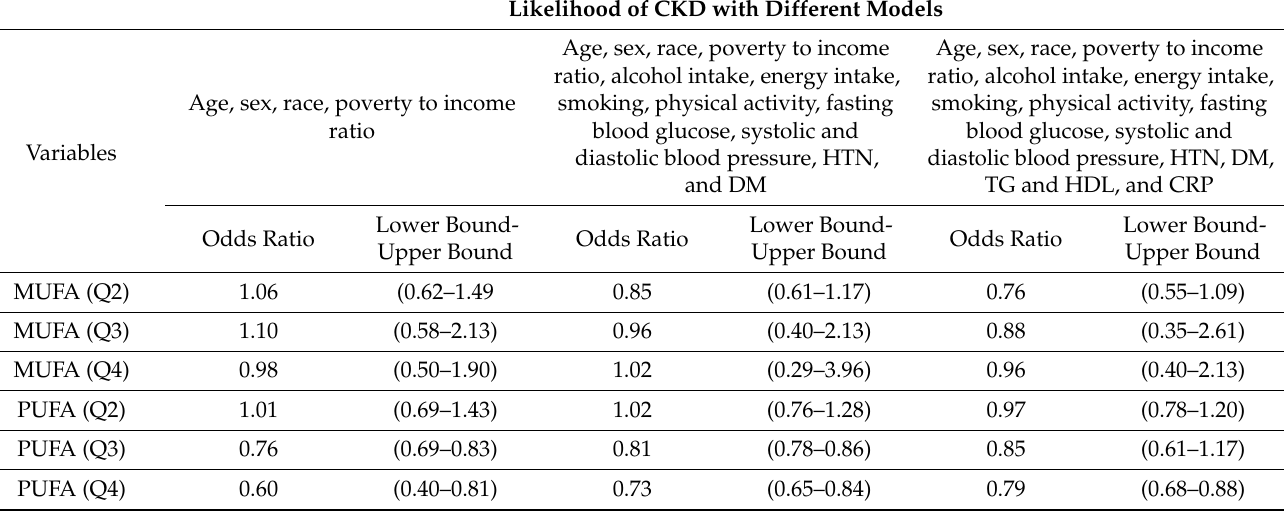
Table 3. Adjusted logistic regression to examine the association between quartiles for mono and polyunsaturated fatty acids and the risk of chronic kidney disease (CKD). Likelihood of CKD with Different